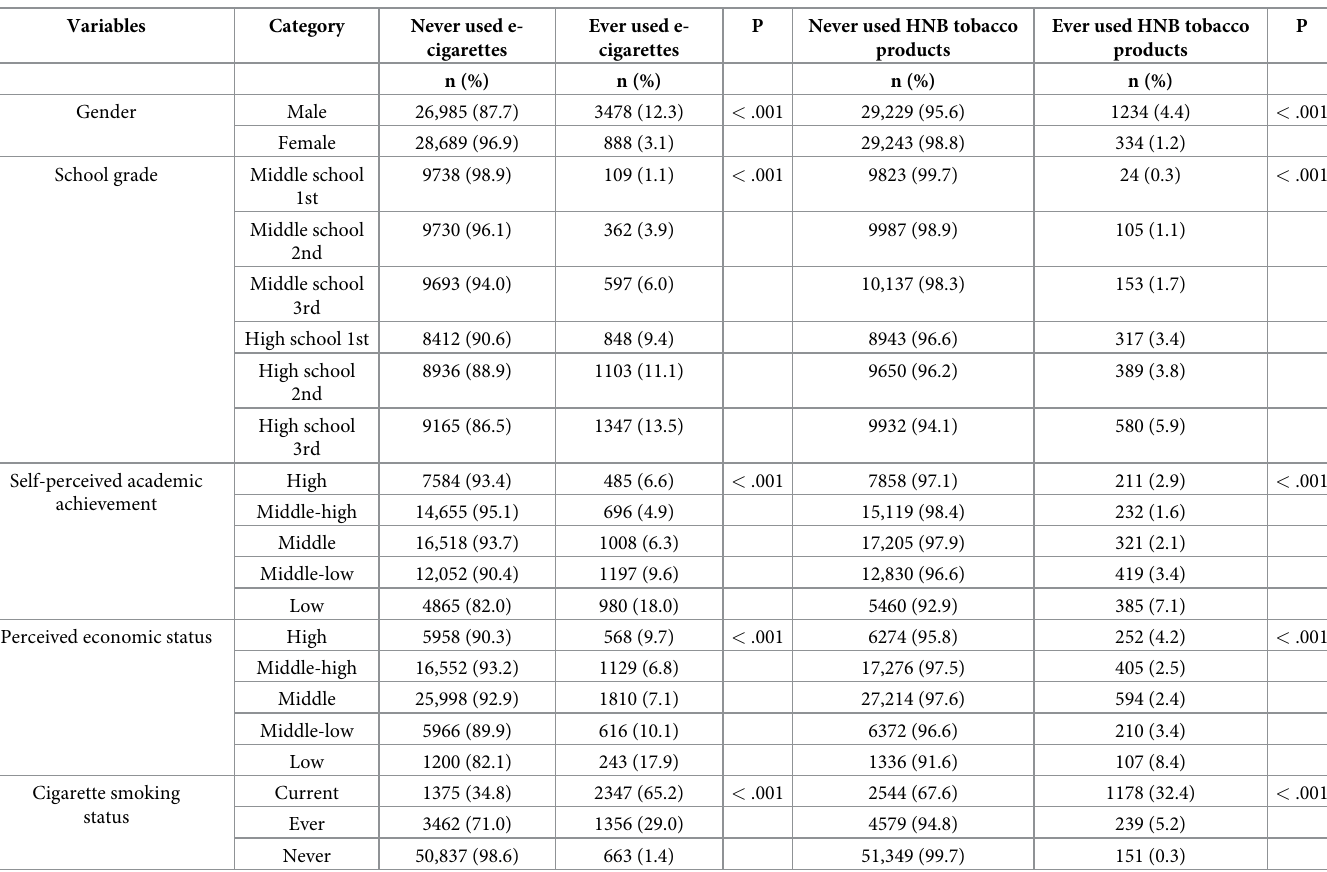
Table 1. Participants’ general characteristics (N = 60,040) 1